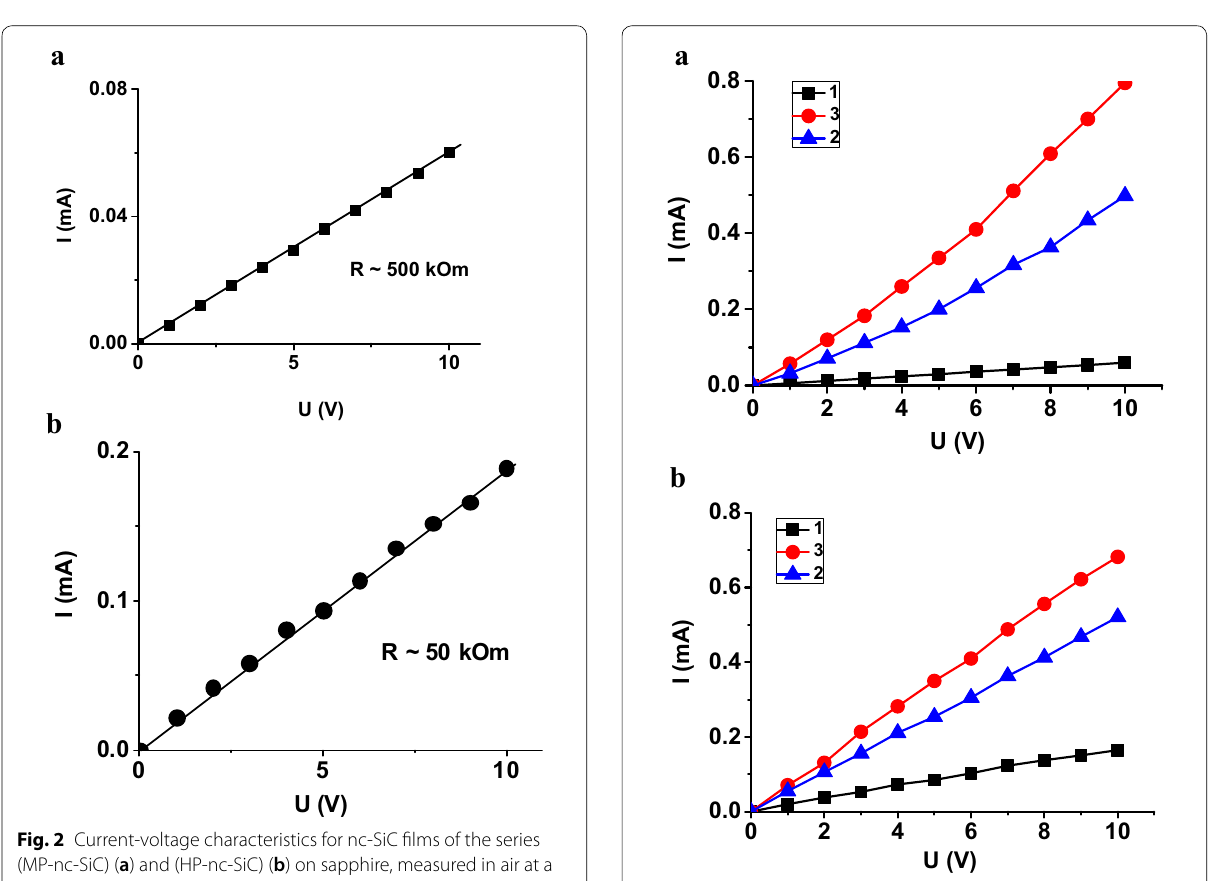
HP-nc-SiC ( b ) films measured in vacuum at p < 10 − 1 Pa at 293 K (1) and annealed in vacuum at 500 K (2) and 700 K